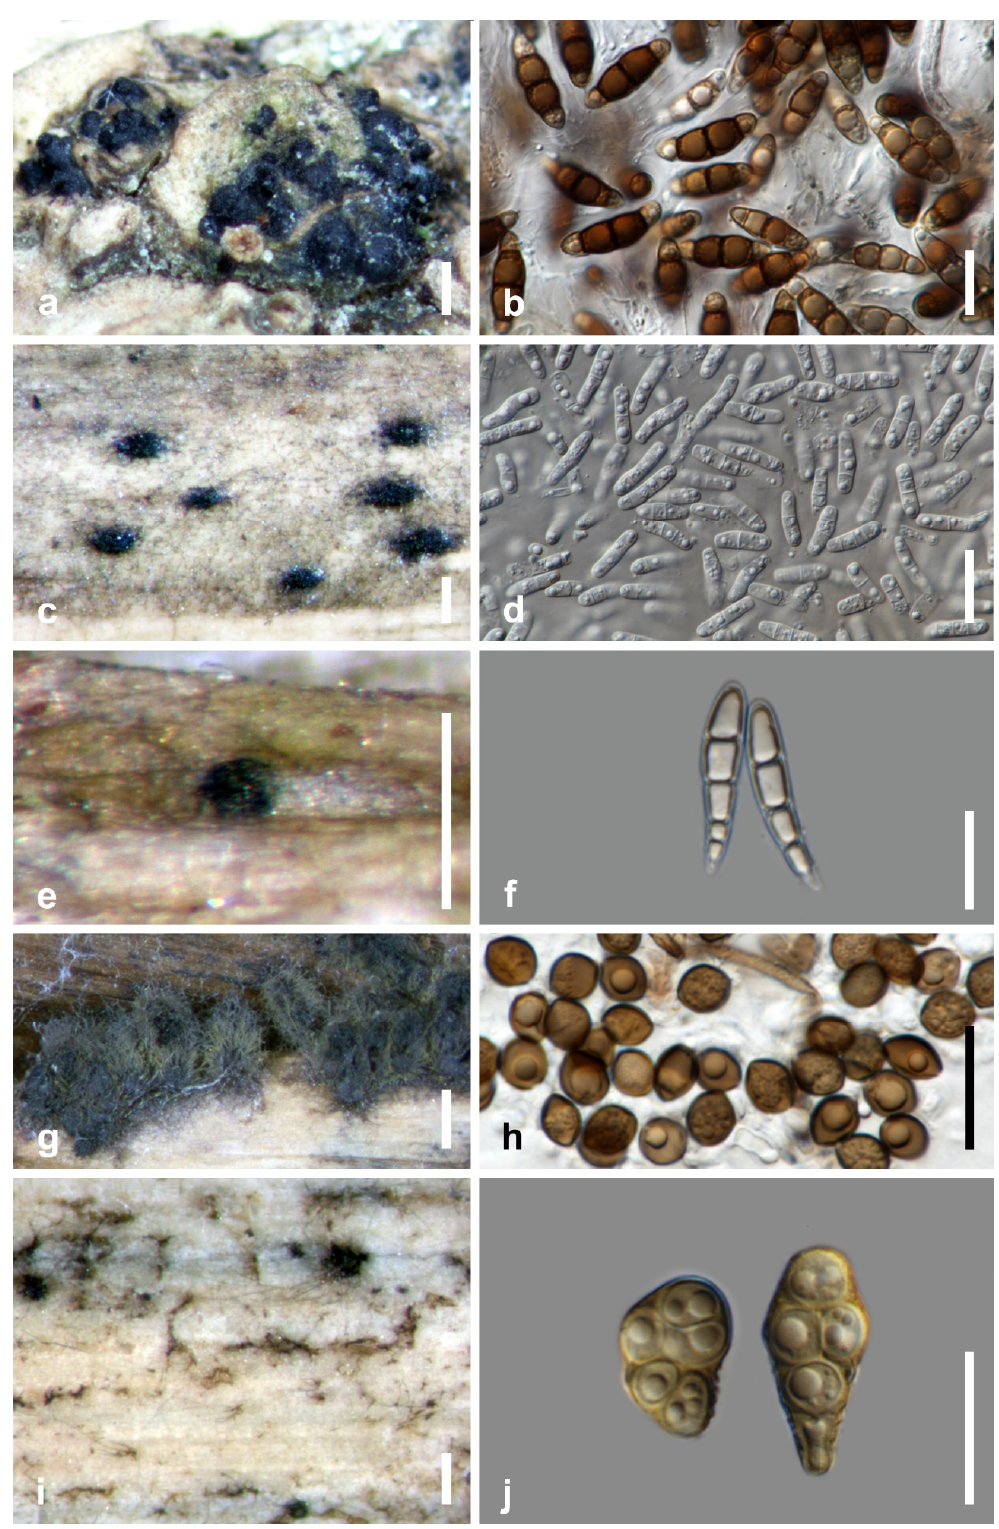
Figure 4. Salt marsh fungi. ( a , b ) Halobyssothecium obiones from Atriplex portulacoides ; ( c , d ) Halobyssothecium phragmites from culms of Phragmites sp.; ( e , f ) Buergenerula spartinae from culms of Spartina sp.; ( g , h ) Chaetomium sp. from stem of Typha sp.; ( i , j ) Alternaria sp. from culms of Spartina sp. Scale bars: ( a , g ) = 500 µm; ( b , d , f , h , j ) = 20 µm; ( c , i ) = 200 µm; ( e ) = 100 µm.